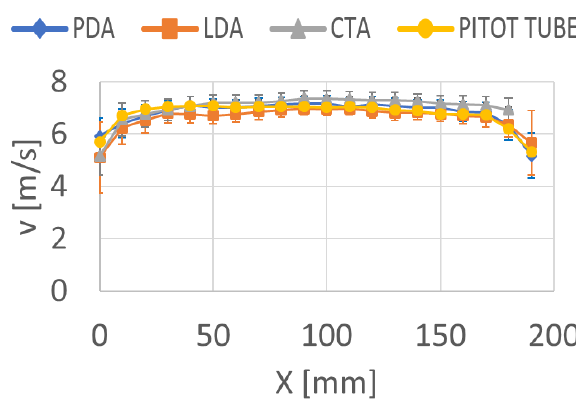
Fig. 10. Velocity profile, mean velocity of 28 m/s .